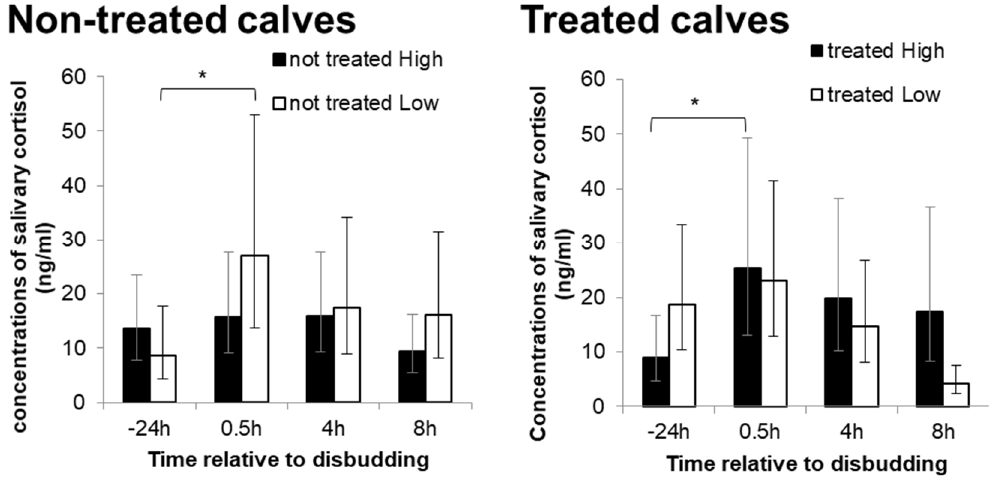
Figure 4. Change in the concentrations of salivary cortisol from baseline (24 h pre-disbudding) to 0.5 h, 4 h and 8 h post-disbudding (back-transformed means and corresponding 95% Cis (confidence intervals).) for calves with no previous disease record in the group pen (left) and calves with a previous disease record in the group pen (right). * indicate significant differences between baseline and 0.5 h post-disbudding within treatments ( p < 0.05).